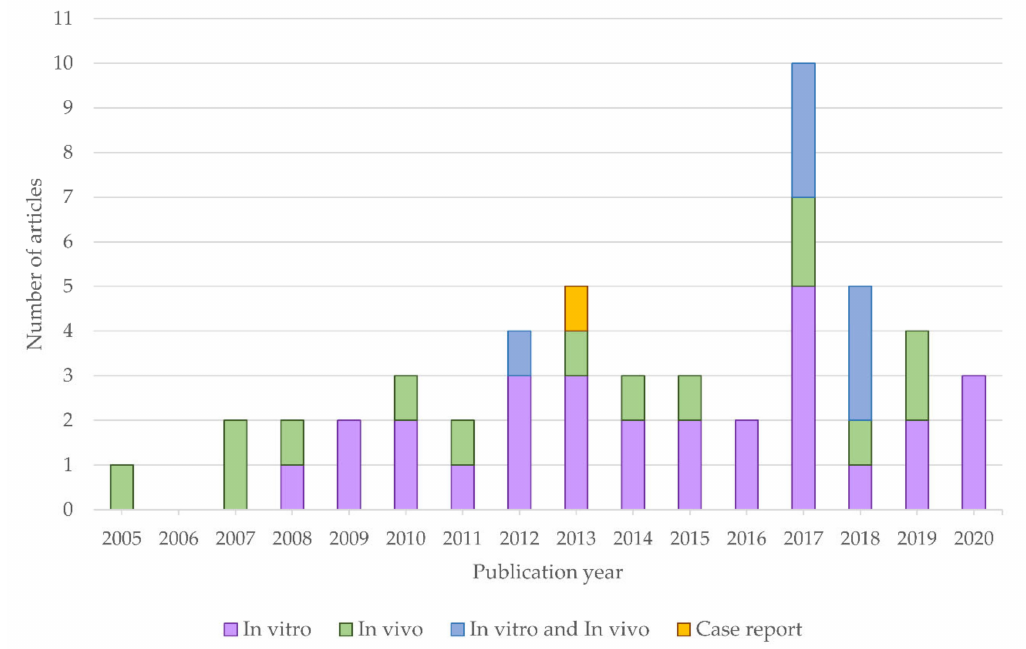
Figure 2. Temporal distribution of the number of articles published after 2004 which evaluate melatonin effects in liver tumors with only in vitro or in vivo models, with both type of models or in a case